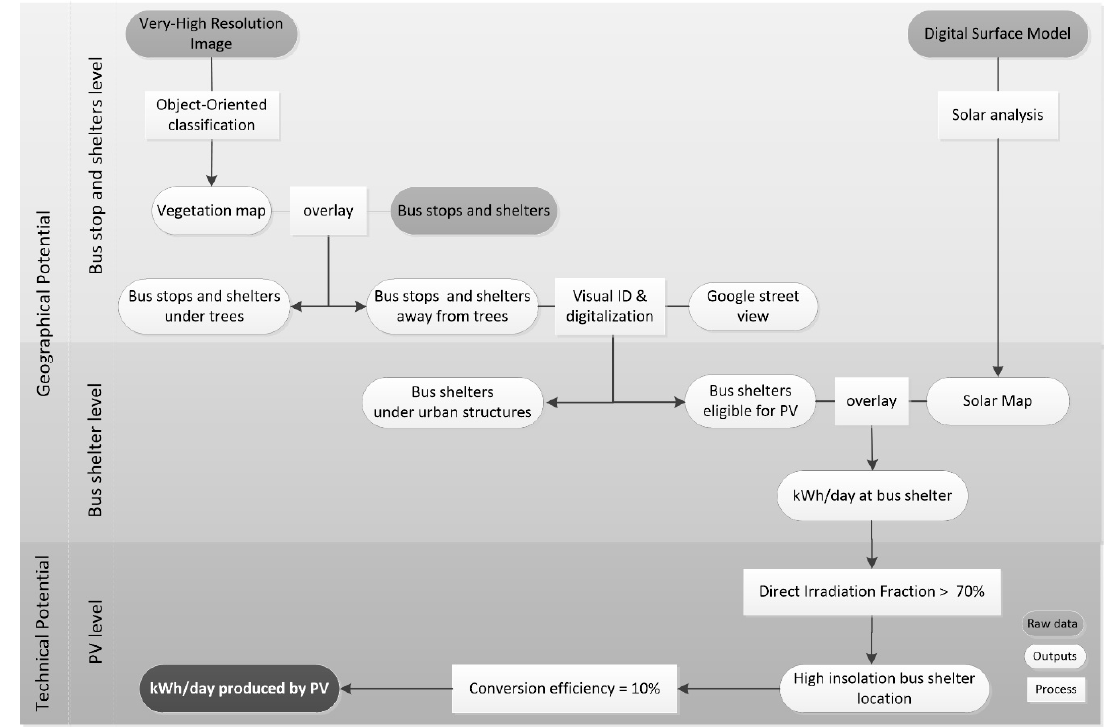
Figure 3. Solar resource analyses at the city scale and selection of the solar bus shelters.